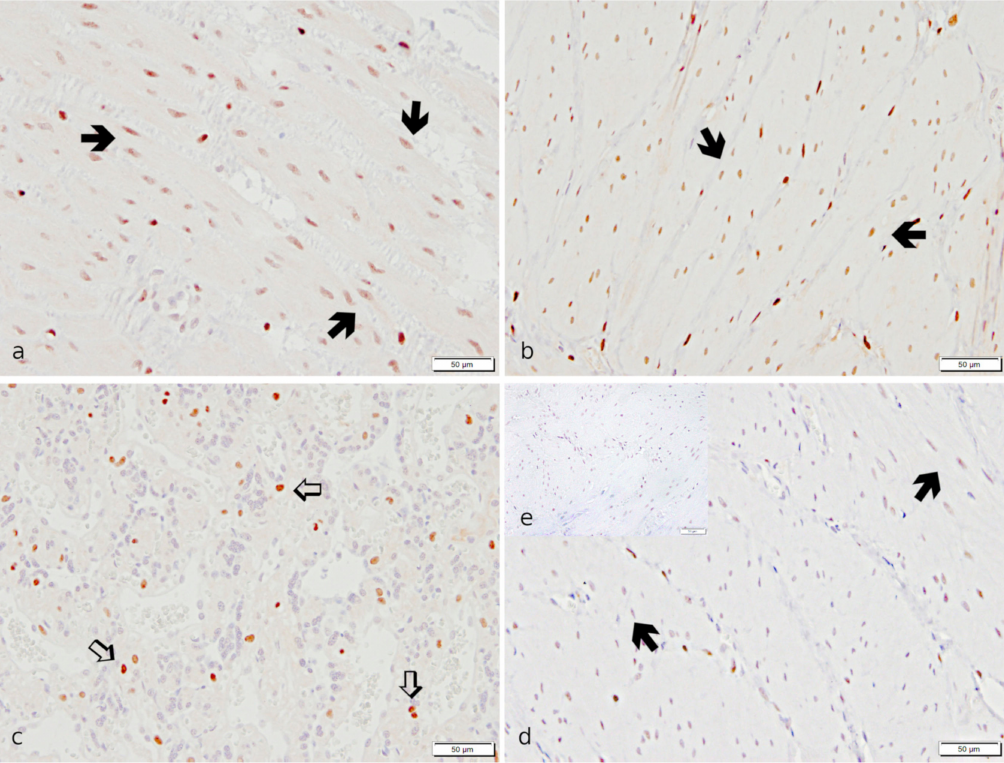
Figure 6. Specific immunostaining for PGR revealed in canine uterine tissue. ( a , b , d ): IP, ( c , e ): UP. ( a , b , d , e ): Myometrium; ( a , d ): Stratum circulare; ( b ): Stratum longitudinale; ( c ): Placenta. Strong immunopositive signals for PGR are visible in myocytes ( (cid:212) , black bold arrow) of both myometrial layers and maternal decidual cells ( (cid:234) , white bold arrow) in the placenta in the PUI group ( a – c ). Myometrial staining appears weaker in OD ( d ) (representative image from the OD group). ( e ) The isotype control is devoid of signals (insert).